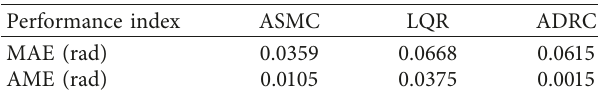
Figure 12: Tracking results of pitch angle under the wind speed of 1.6m/s. Table 3: Comparison of the roll tracking performance under the wind speed of 1.6m/s.